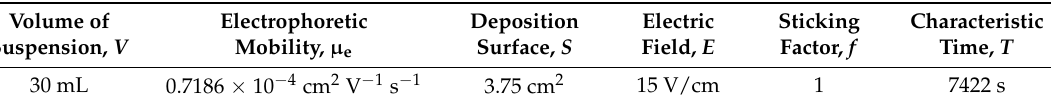
Figure 5. Picture and Micrographs at different magnifications of a Nickel foam coated with NiO/Ni particles.